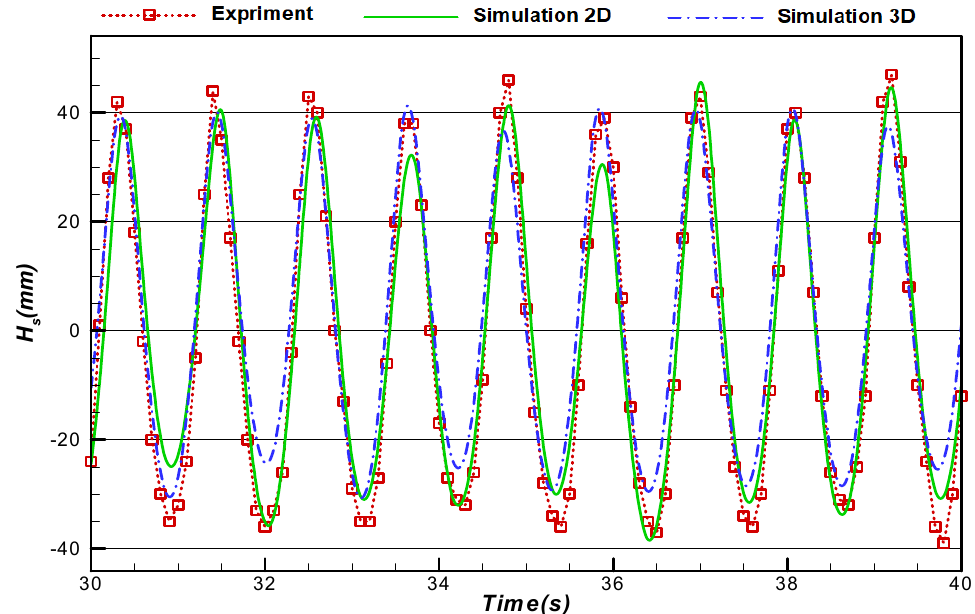
Figure 14. Comparison of two-dimensional, three-dimensional, and experimental results.